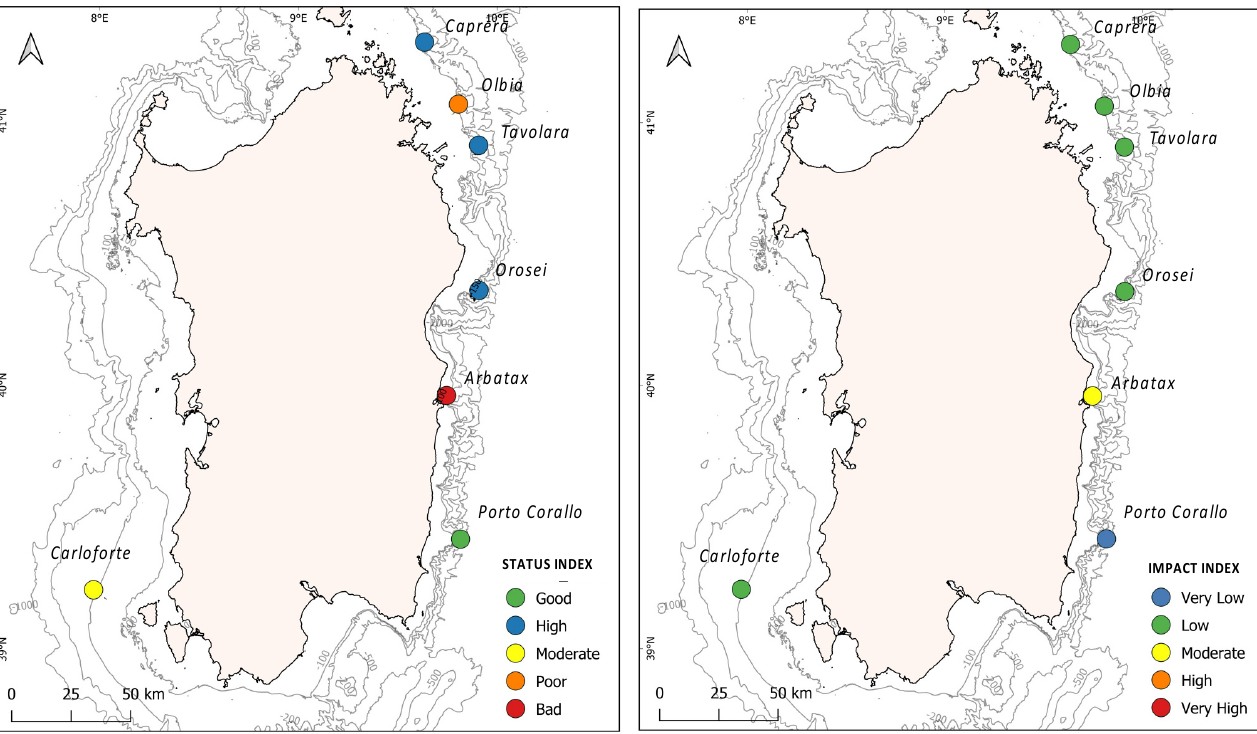
Figure 4. Results of the Index of Status (I s ), Index of Impact (I i ), and MACS Index for the seven investigated sites. Refer to Tables S1 and 1 for site identifications and index results. The relationship between the seven investigated forests characterized by their envi- ronmental status and geomorphological variables (depth, slope, TPI, and TRI) are pre- sented in the CCA triplot (Figure 5). The first two axes accounted for 93% of the total variance (axis 1 = 63%; axis 2 = 30%), and the permutation test was significant (eigenvalue for axis 1 = 0.07 and for axis 2 = 0.04, p < 0.05). The CCA plot showed that axis 1 was